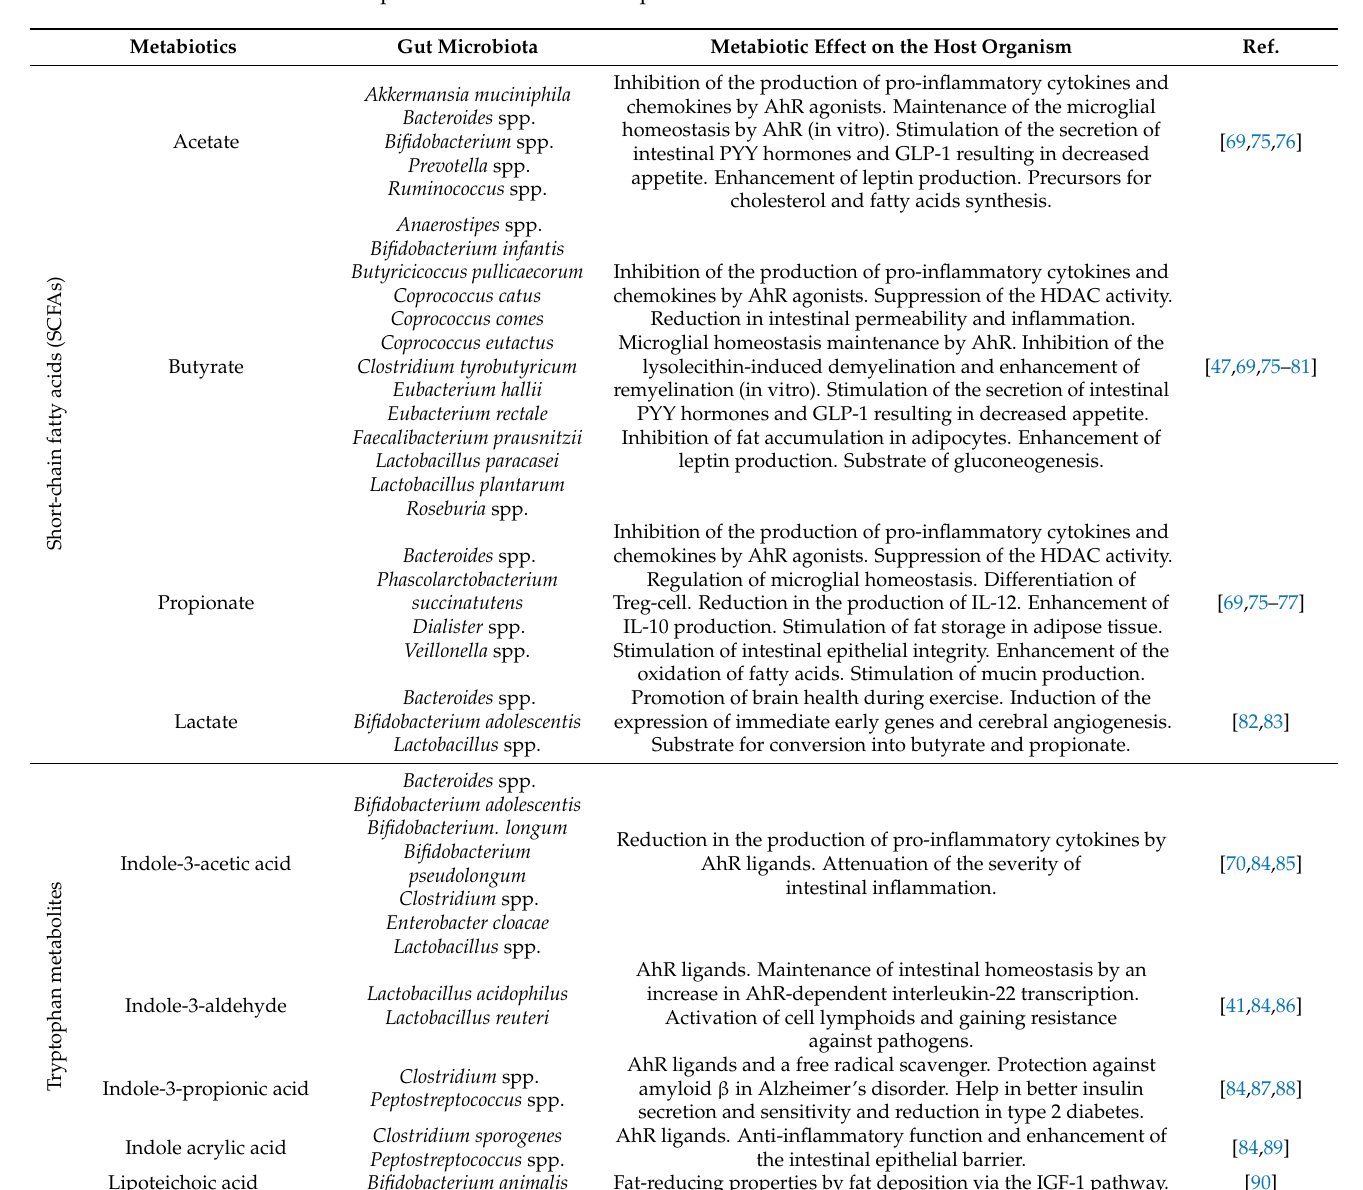
Table 1. Neuroactive metabiotics of intestinal microbiota in a healthy organism and their effects on depression and metabolic